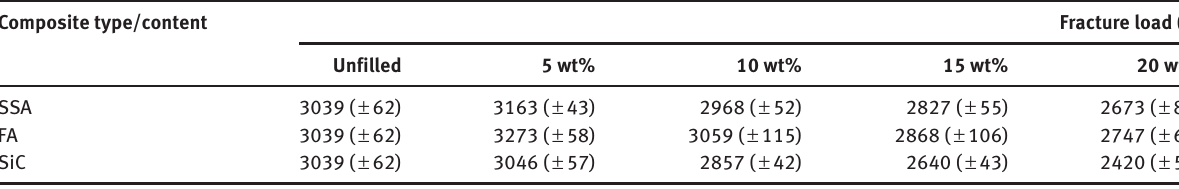
Table 4: Fracture loads of TPB test for un-notched specimens. Composite